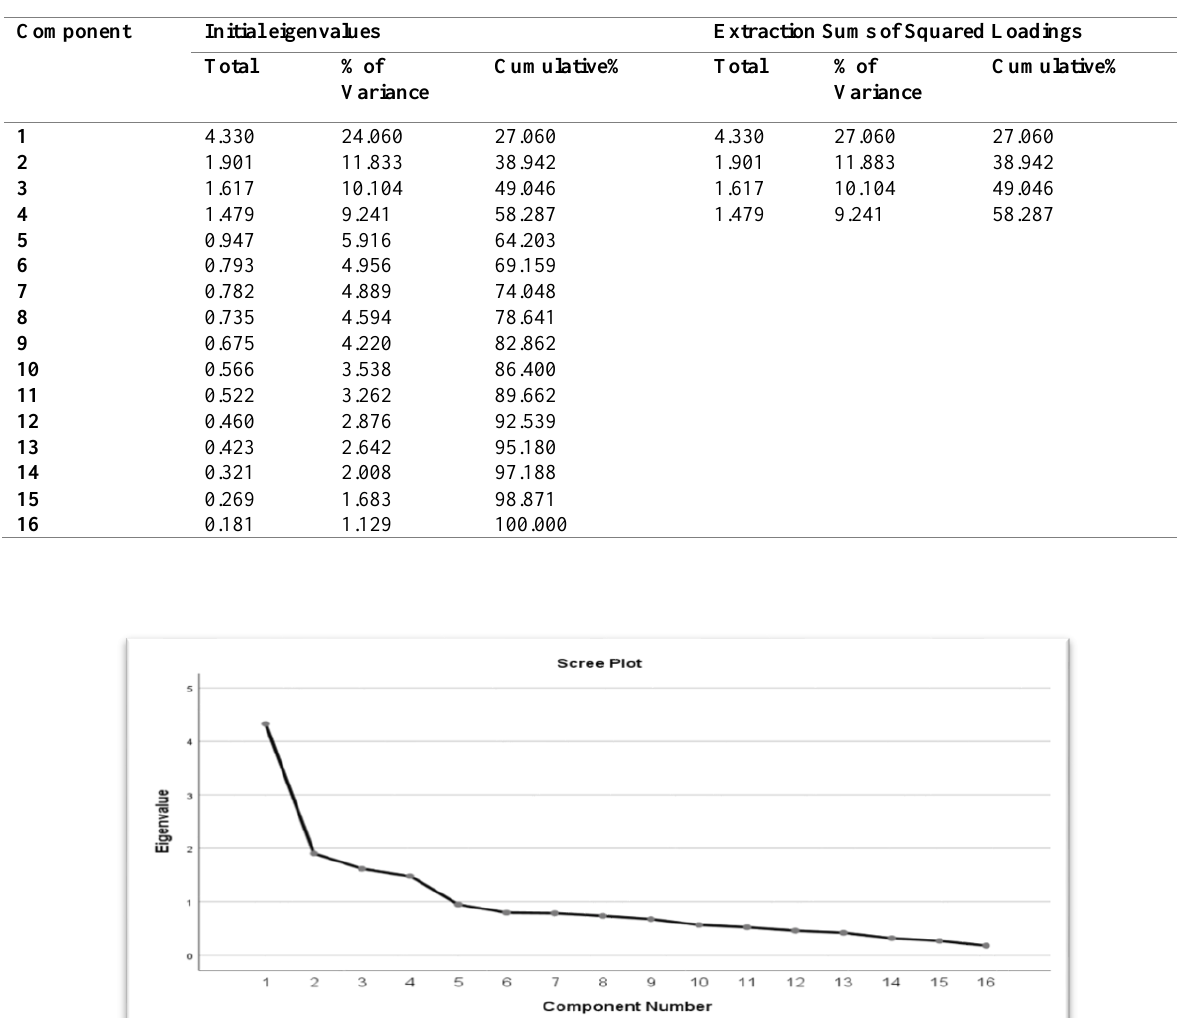
Table 5: Total Variance Explained Output